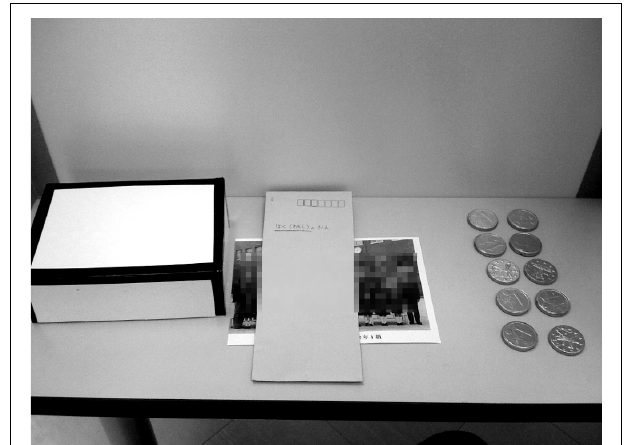
FIGURE 2 | Photograph of the experimental environment in the private condition. In the public condition, the vertical plastic boards and the lids of the boxes were